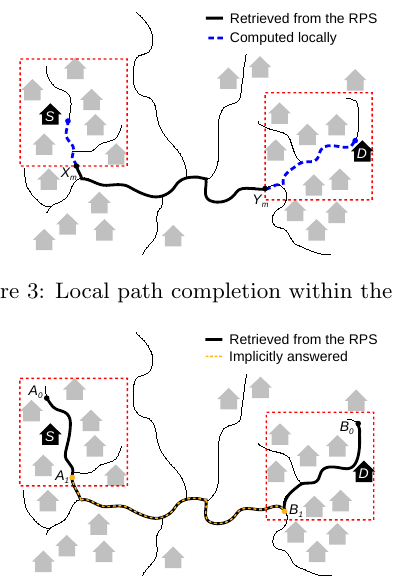
Figure 4: Redundant queries to the RPS can be avoided by discarding routes learned implicitly from previous requests.